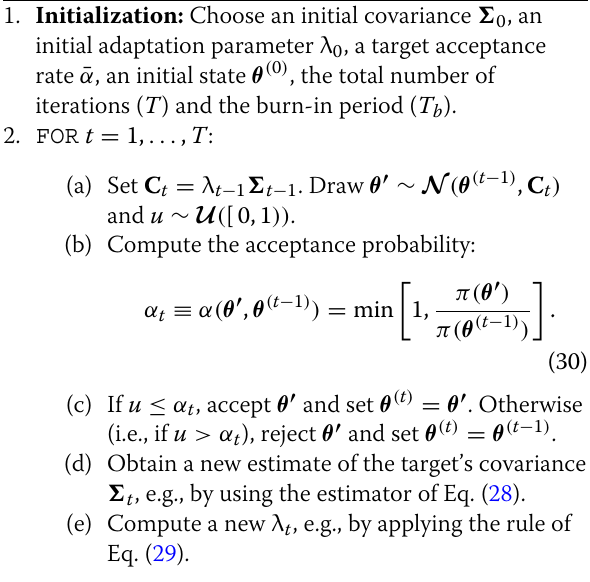
Algorithm 12 General Adaptive Metropolis (AM) Algo-